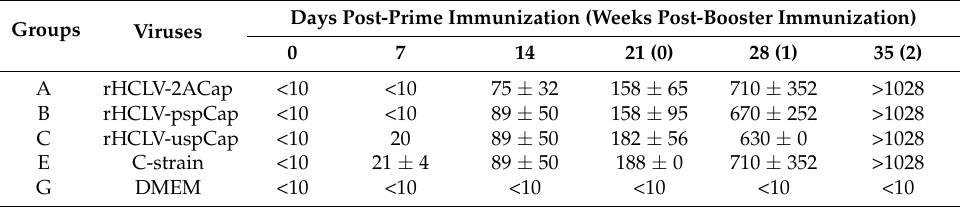
Table 4. Anti-CSFV neutralizing antibody titers in the sera from the inoculated rabbits. Groups